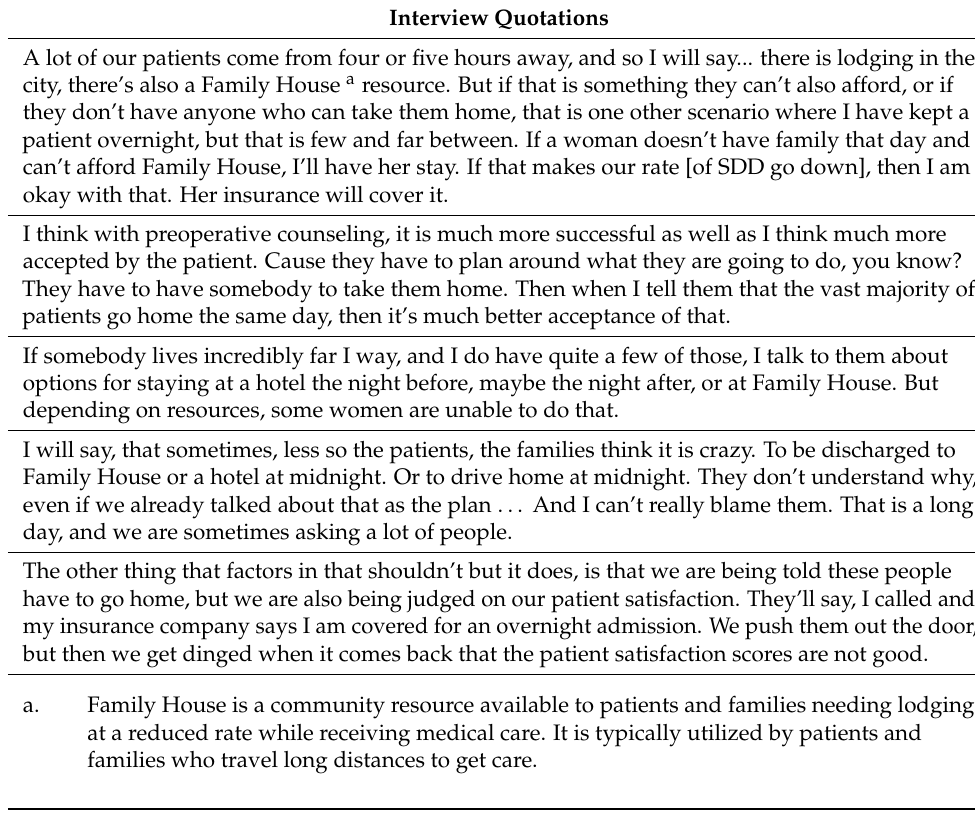
Table 5. Travel concerns and preoperative